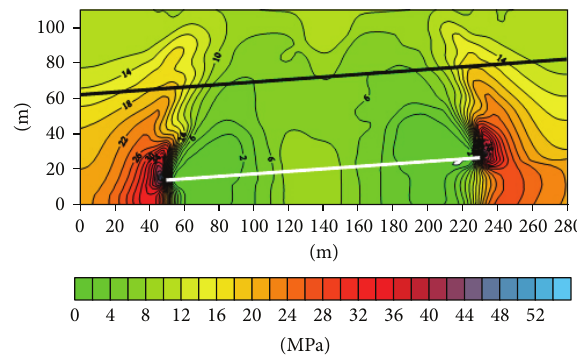
Figure2:Theverticalstressprofilealongtheworkingfacedirection.